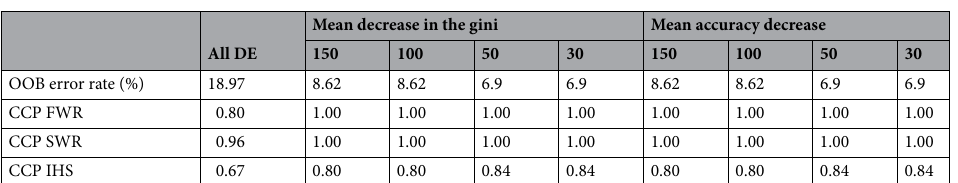
Table 1. OOB error rate (%) and the CPP of the different gene sets: all differentially expressed, and top 150, 100, 50 and 30 bases on Mean Decrease in the Gini and Mean Accuracy Decrease. CCP = (1-classification